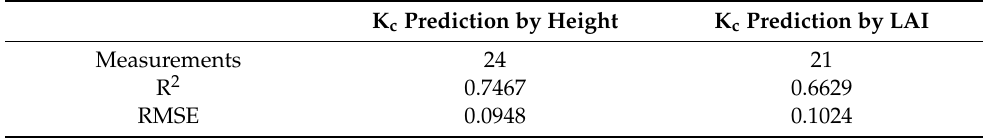
Table 9. K c prediction models based on field measurements of processing tomatoes height and